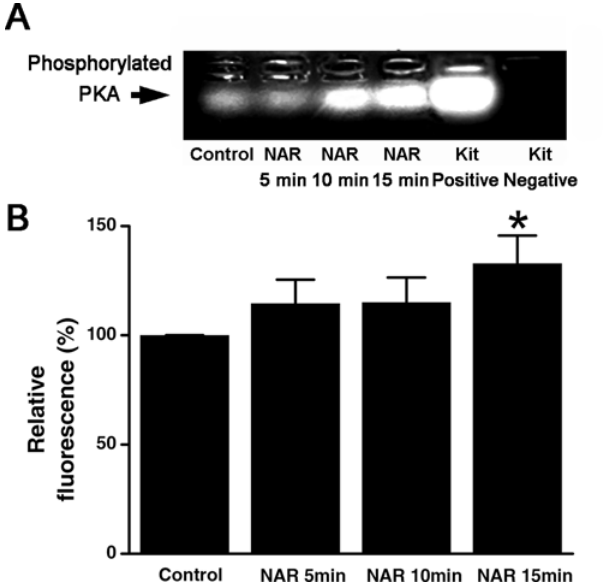
Figure 6. Effect of naringenin on the PKA activity. A, colonic mucosa was treated with DMSO alone (control) or 100 m M naringenin for 5, 10 and 15 min. The positive and negative controls provided by the assay kit are shown in lanes 5 and 6. B, summarized data showing the relative grey value as compared with control. Each column represents the mean 6 S.E. (*p , 0.05).